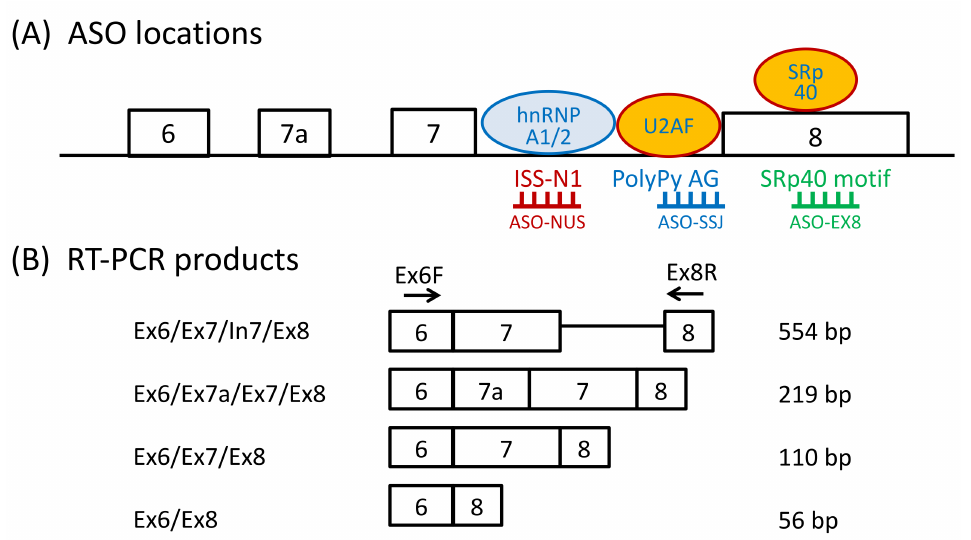
Figure 1. The locations of antisense oligonucleotides (ASOs) and reverse transcription-polymerase chain reaction (RT-PCR) products. ( A ) The targeting sites of ASOs (red, blue, and green lines) used in this study and their respective binding motifs. The numbered boxes and black lines represent the survival motor neuron 2 ( SMN2 ) exons and introns, respectively. ( B ) The primers’ locations and RT- PCR products. The numbered boxes and black lines represent SMN2 exons and introns, respectively. The sizes and composition of the transcript products are stated on the right and left of the figure. Abbreviations: hnRNPA1/2 (Heterogeneous nuclear ribonucleoprotein A 1/2); U2AF (U2 auxiliary factor); SRp40 (SR Protein 40); ISS-N1 (Intronic splicing silencer N1); PolyPy (polypyrimidine tract); AG (AG dinucleotide at 3’ splice